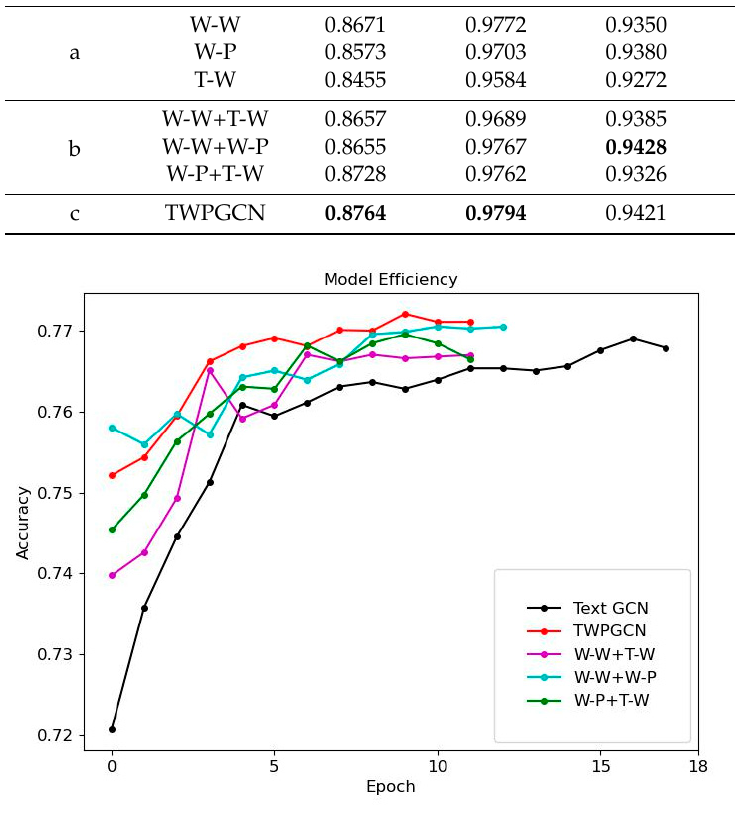
Figure 4. Efficiency comparison experiment .